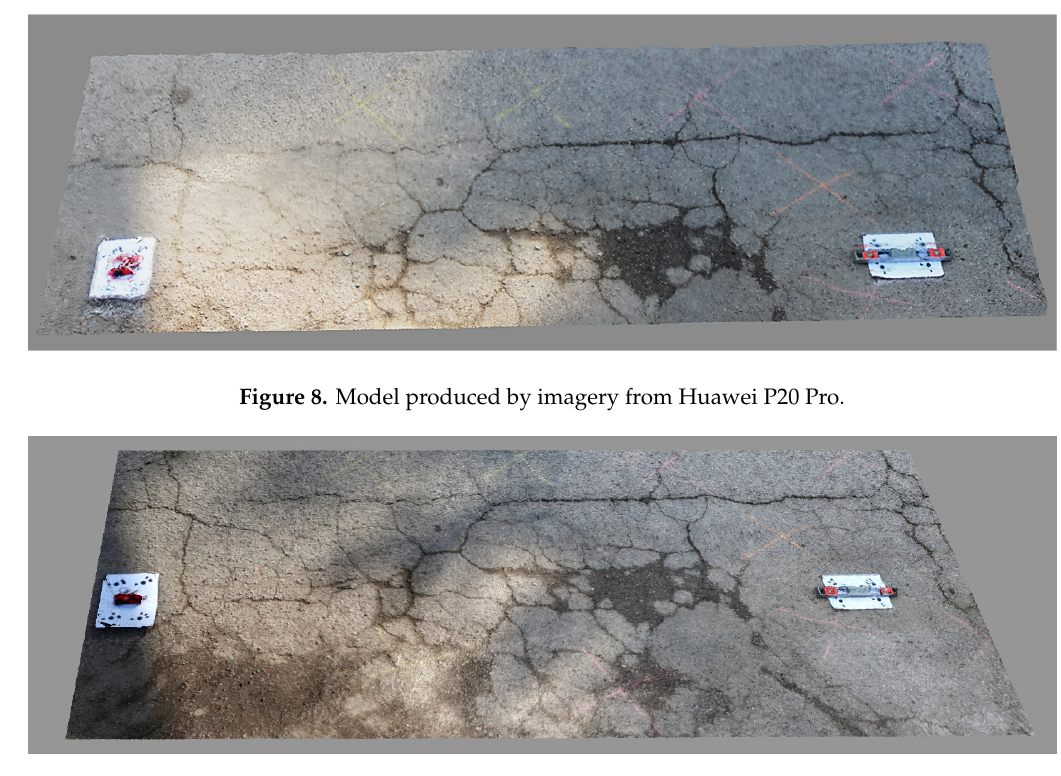
Figure 7. Model produced by imagery from camera.